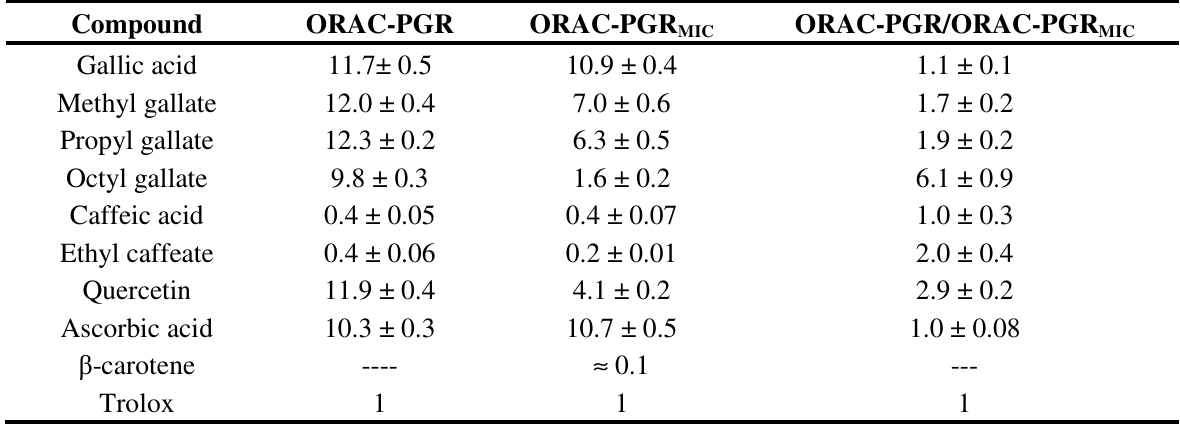
values of pure MIC